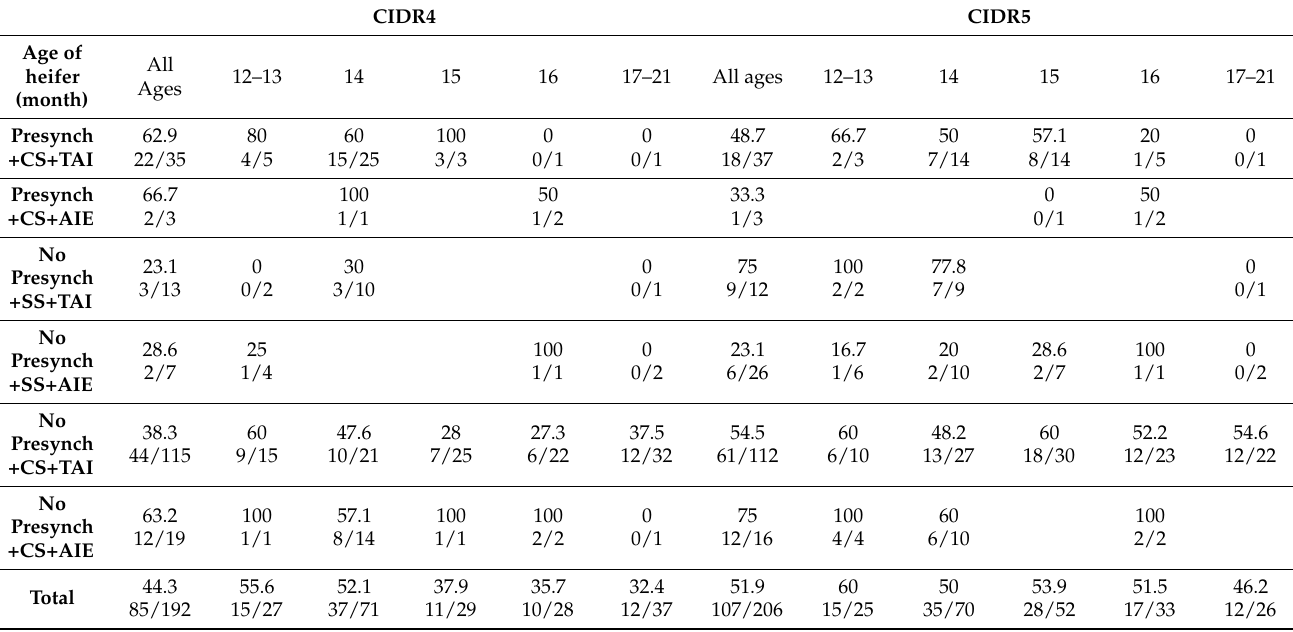
SS : Sexed semen; CS : Conventional semen; TAI : Timed Artificial Insemination, AIE : AI on detected estrus. * In presynchronized heifers, sexed semen was not used. After CIDR removal, there was no difference for rates of AIE between CIDR-4 (15.1%, [29/192]) and CIDR-5 (21.8%, [45/206]) groups. Logistic regression analysis stepwise procedure indicated significant effects of age of heifer and presynchronization on rates of AIE. In this matter, rates of AIE were 6.88 (2.20–21.47) times higher ( p < 0.01) in